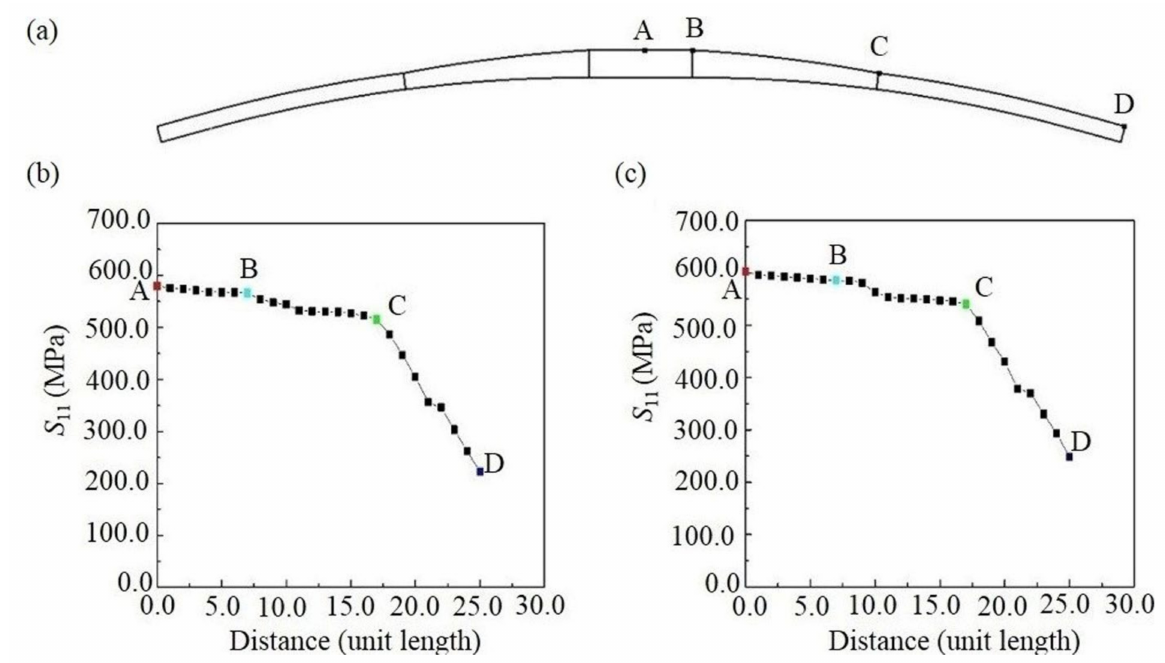
Figure 10. ( a ) Schematic diagram of representative nodes of composite leaf spring, and the normal stress along length direction S 11 of composite leaf spring ( b ) under full loading condition and ( c ) under limit loading condition, where point A, B, C and D in the figure denotes the center, the start of the variable width section, the start and the end of the constant width section of composite leaf spring,